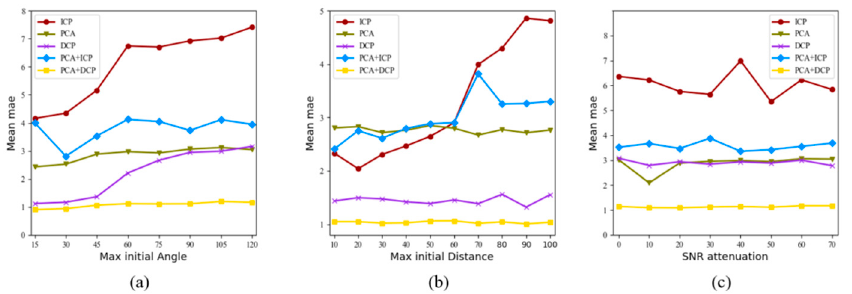
Figure 11. Experiment results on robustness. ( a ) Mean MAE on different initial angles; ( b ) mean MAE on the different initial distances; ( c ) mean MAE on noisy data.